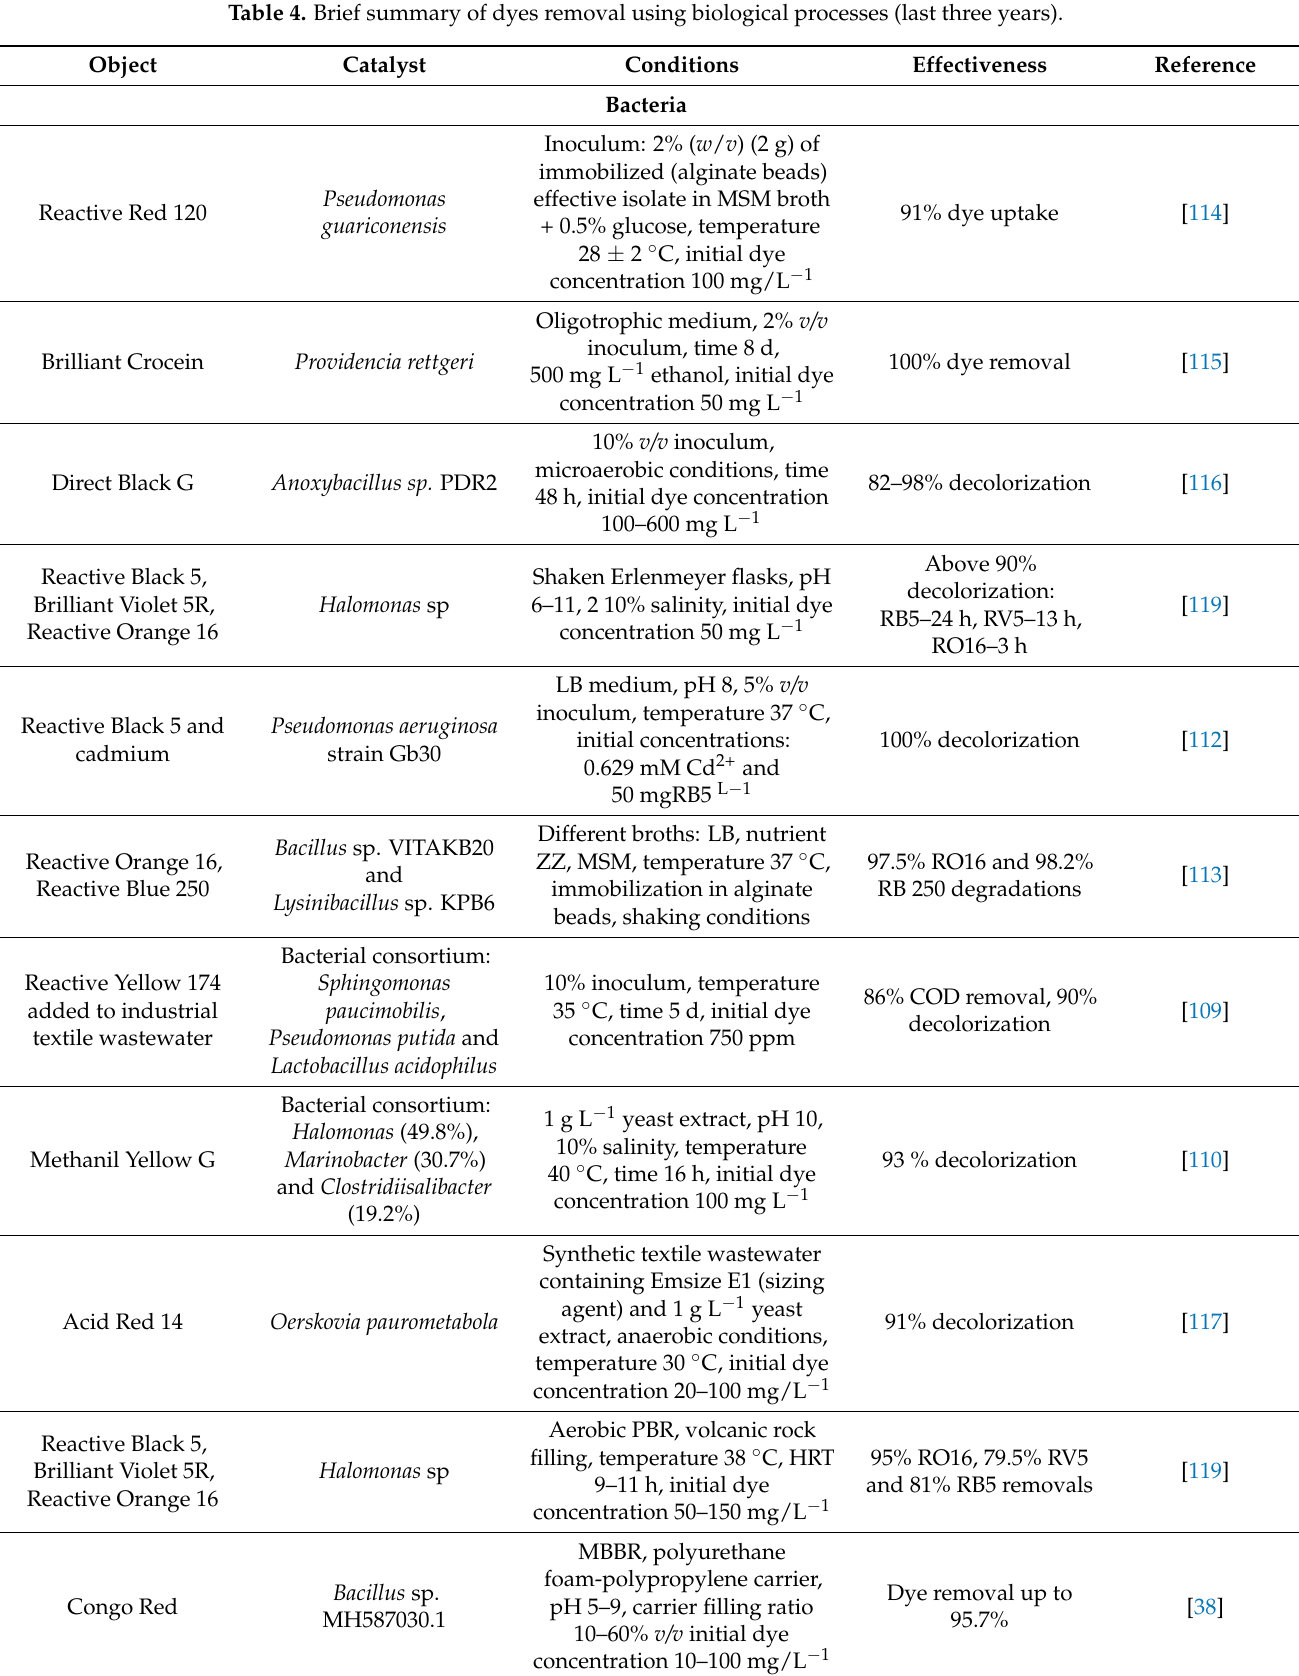
Table 4. Brief summary of dyes removal using biological processes (last three